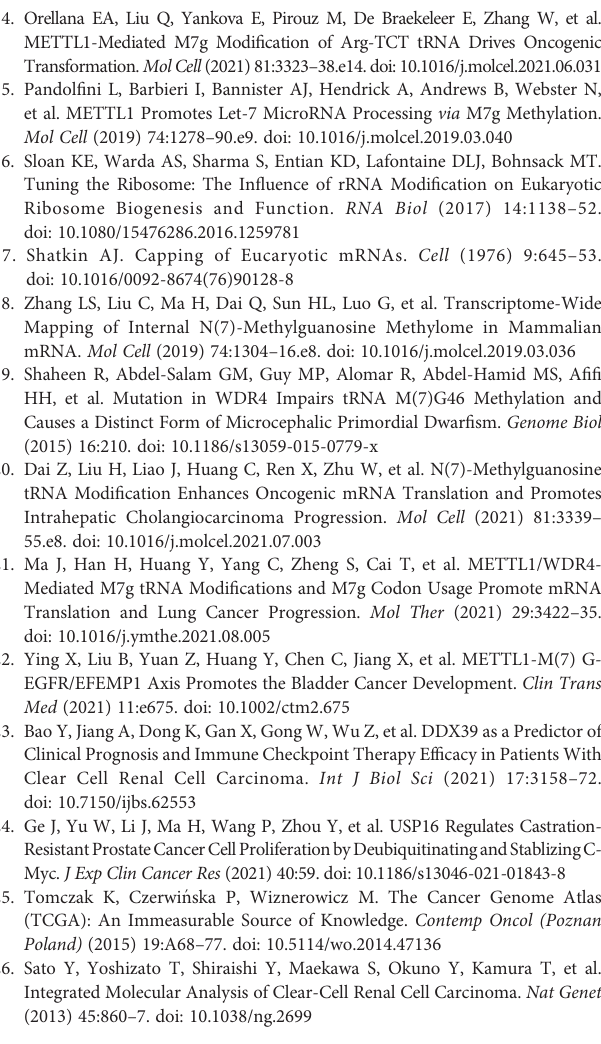
Supplementary Figure 4 | Immune status among three subgroups. (A) Heatmap of the expression of immune-related genes among MGCS1, MGCS2, and MGCS3. (B) Differences in StromalScore, ImmuneScore, and ESTIMATEScore among MGCS1, MGCS2, and MGCS3. Supplementary Figure 5 | CNV alteration in three subgroups. (A) Barplot of genomic fractions altered in the three identi fi ed subtypes of ccRCC. (B) The GISTIC score of copy number pro fi les of ccRCC. (C) The gain (orange) and loss (blue) percentage of copy number pro fi les of ccRCC. Supplementary Figure 6 | Correlation of m 7 G regulators expression level and IC50 of different drugs obtained from CellMiner database. Supplementary Figure 7 | Veri fi cation of m 7 G-related subtypes in external datasets. (A) Heatmap of the expression pro fi les of m 7 G regulators in three subtypes of GDSC renal cancer cells database. (B) Drug sensitivity values for 8 compounds in the form of normalized AUC on renal cancer celllines supplied by the GDSC database. (C) Heatmap of NTP in Japan cohort using subtype-speci fi c upregulated signature identi fi ed from TCGA-ccRCC cohort. (D) Kaplan-Meier survival curve of the three predicted subtypes of renal cancer in Japan cohort. Supplementary Figure 8 | Veri fi cation of m7Sig in Japan cohort. (A) m7Sig risk score analysis of patients in Japan cohort. (B) Kaplan-Meier analysis for OS of the